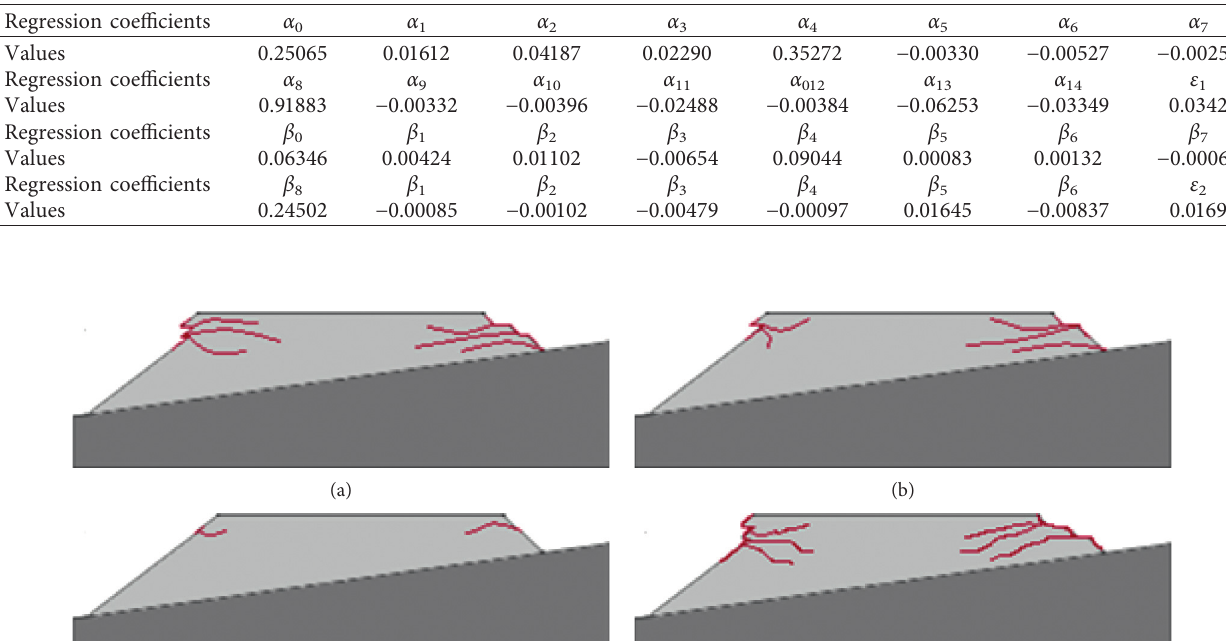
� F � F � 0 and PGA � 1.2g). (a) Seismic damages of R � 1km 1 2 3